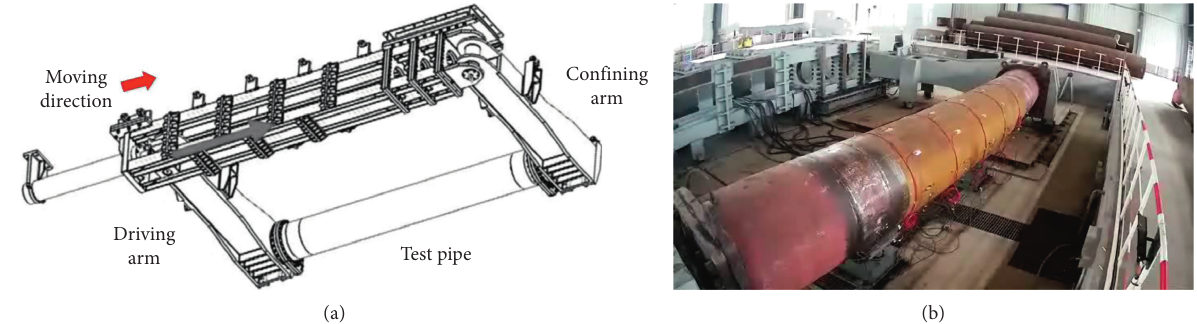
Figure 4: Layout of large-scale pipe mechanical loading experiment: (a) schematic diagram; (b) site